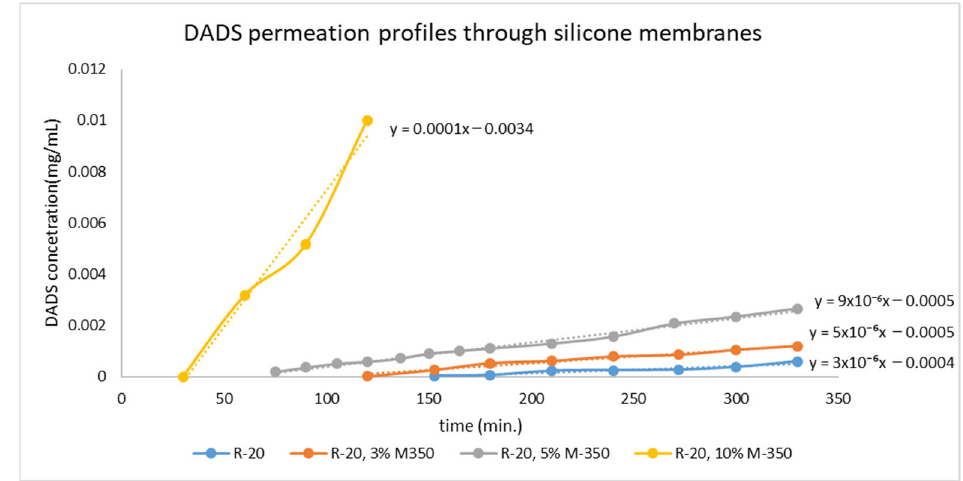
Figure 2. DADS permeation through different silicone membranes. Table 1. Diffusivities and time lags of different silicone membranes.